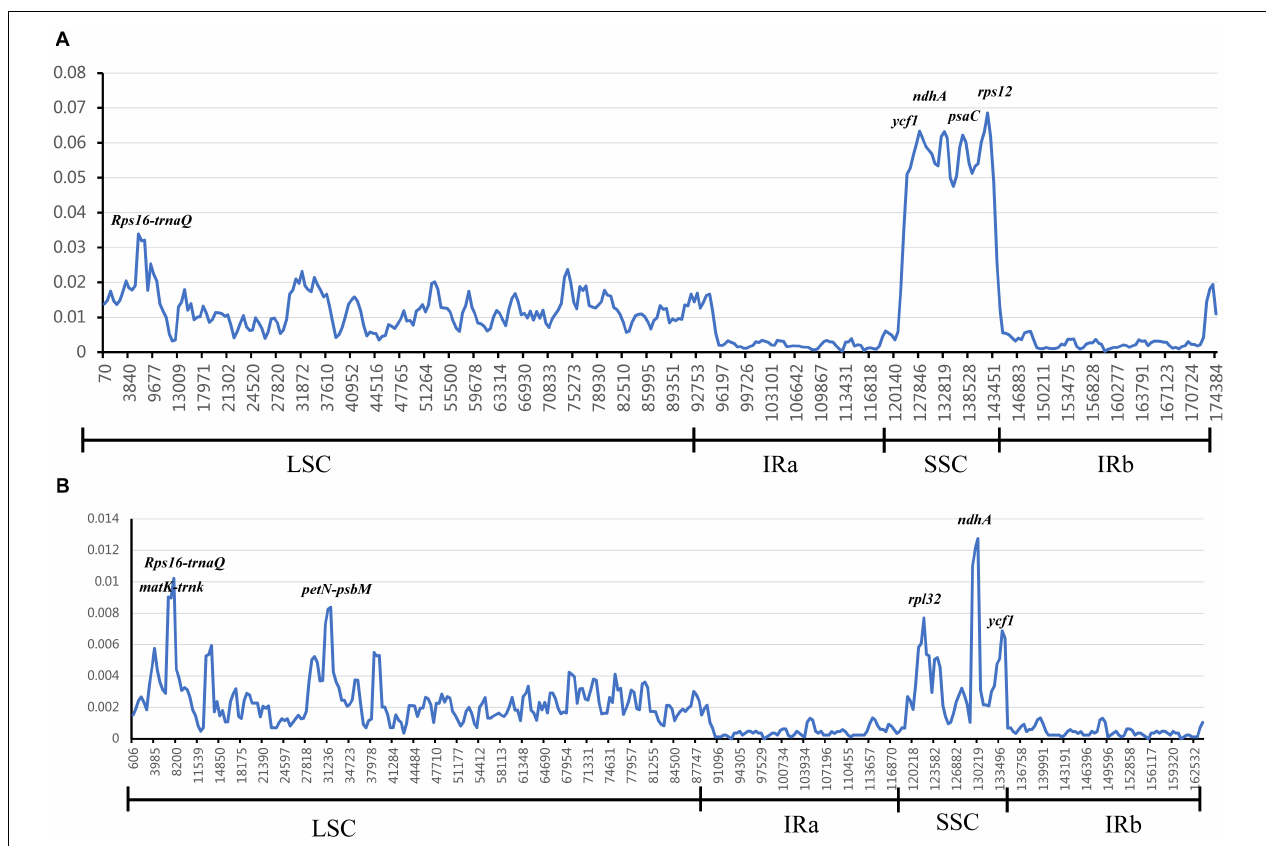
FIGURE 6 | Sliding window analysis of 25 Zingiberaceae chloroplast genomes. The nucleotide variability (Pi) value in: (A) 25 Zingiberaceae species; (B) 14 Curcuma